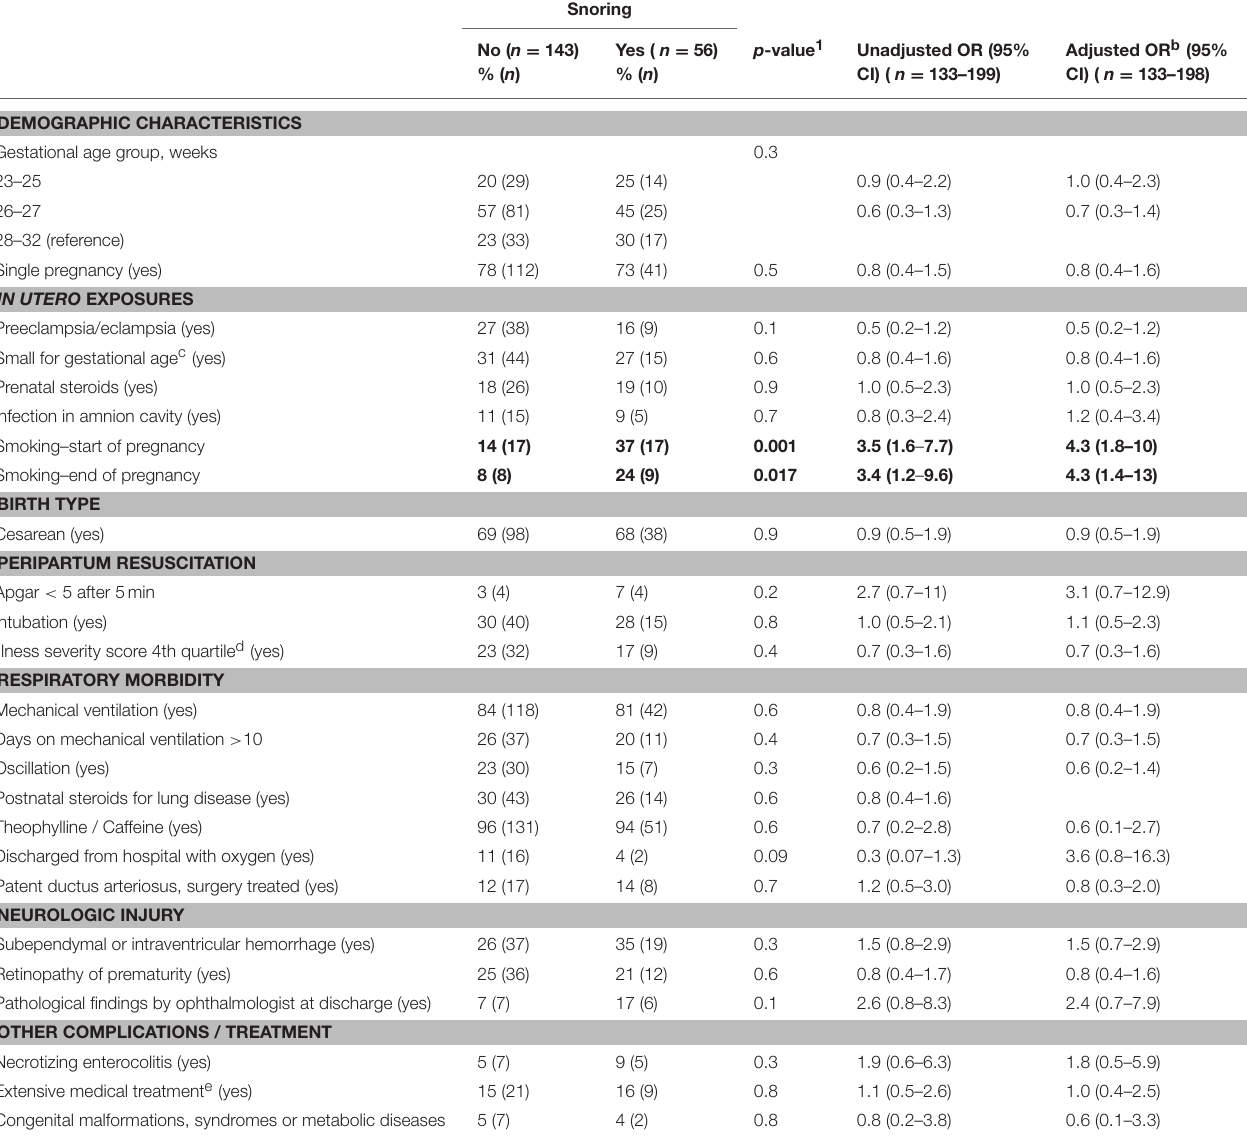
TABLE 4 | Prenatal and neonatal factors predicting snoring at 11 years of age among children born extremely preterm a